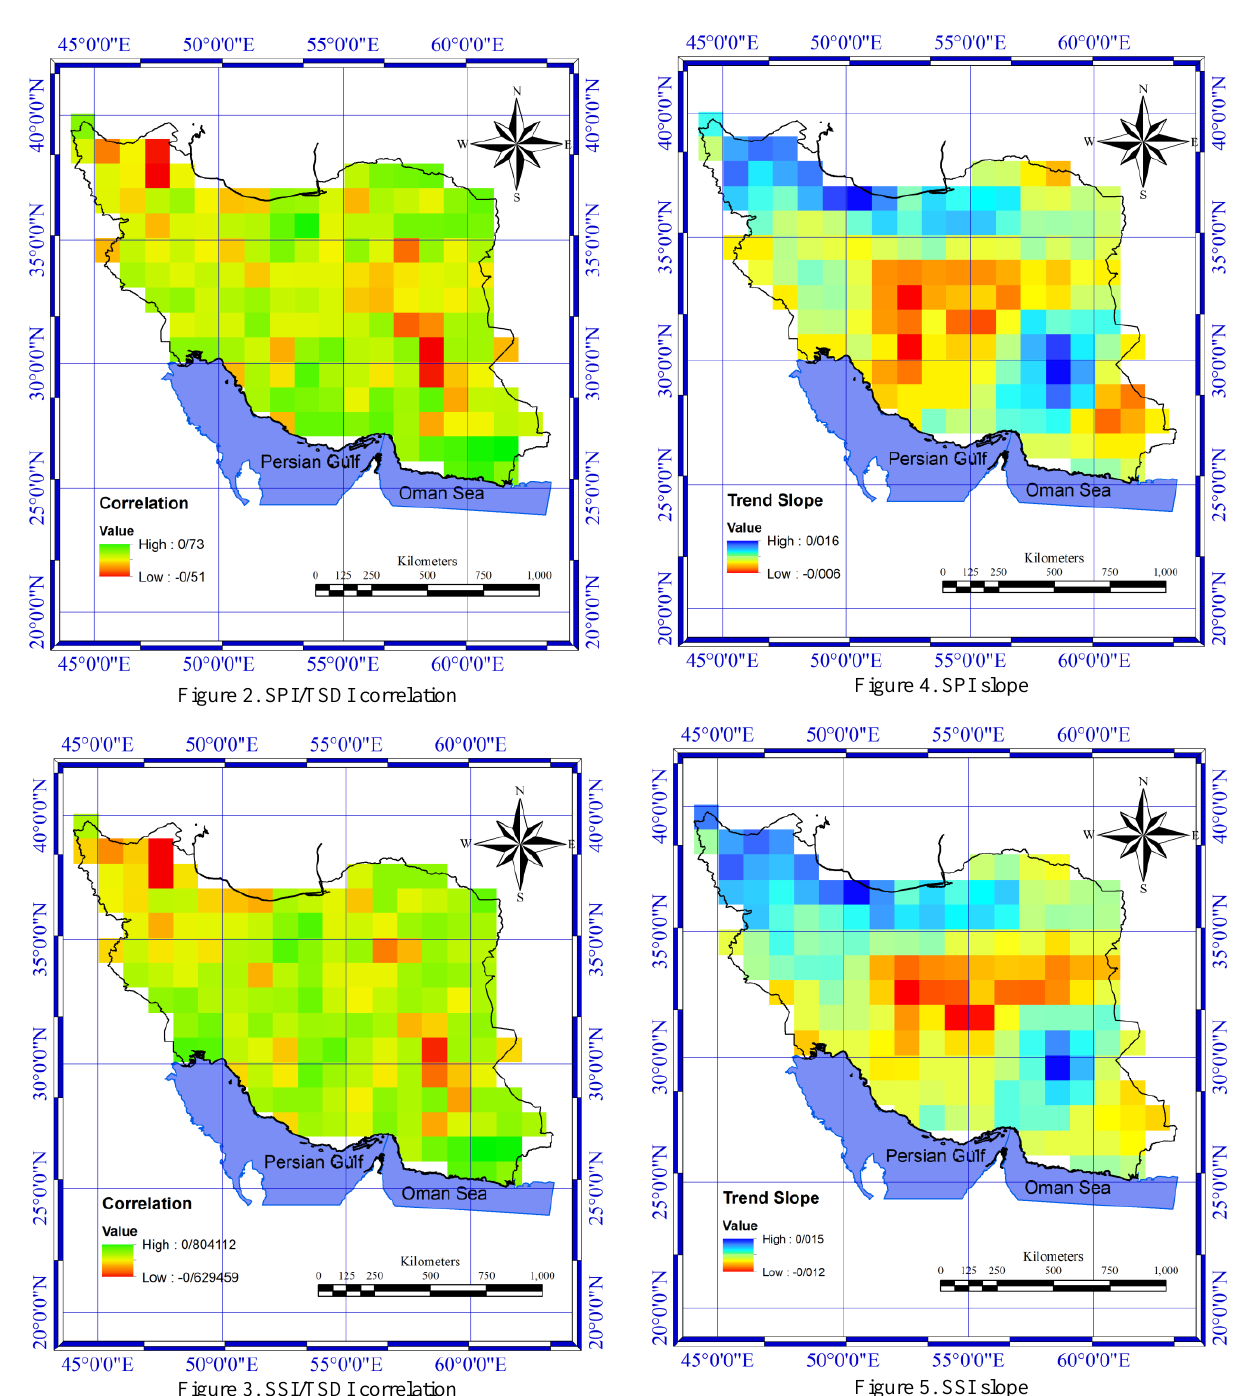
Figure 3. SSI/TSDI correlation